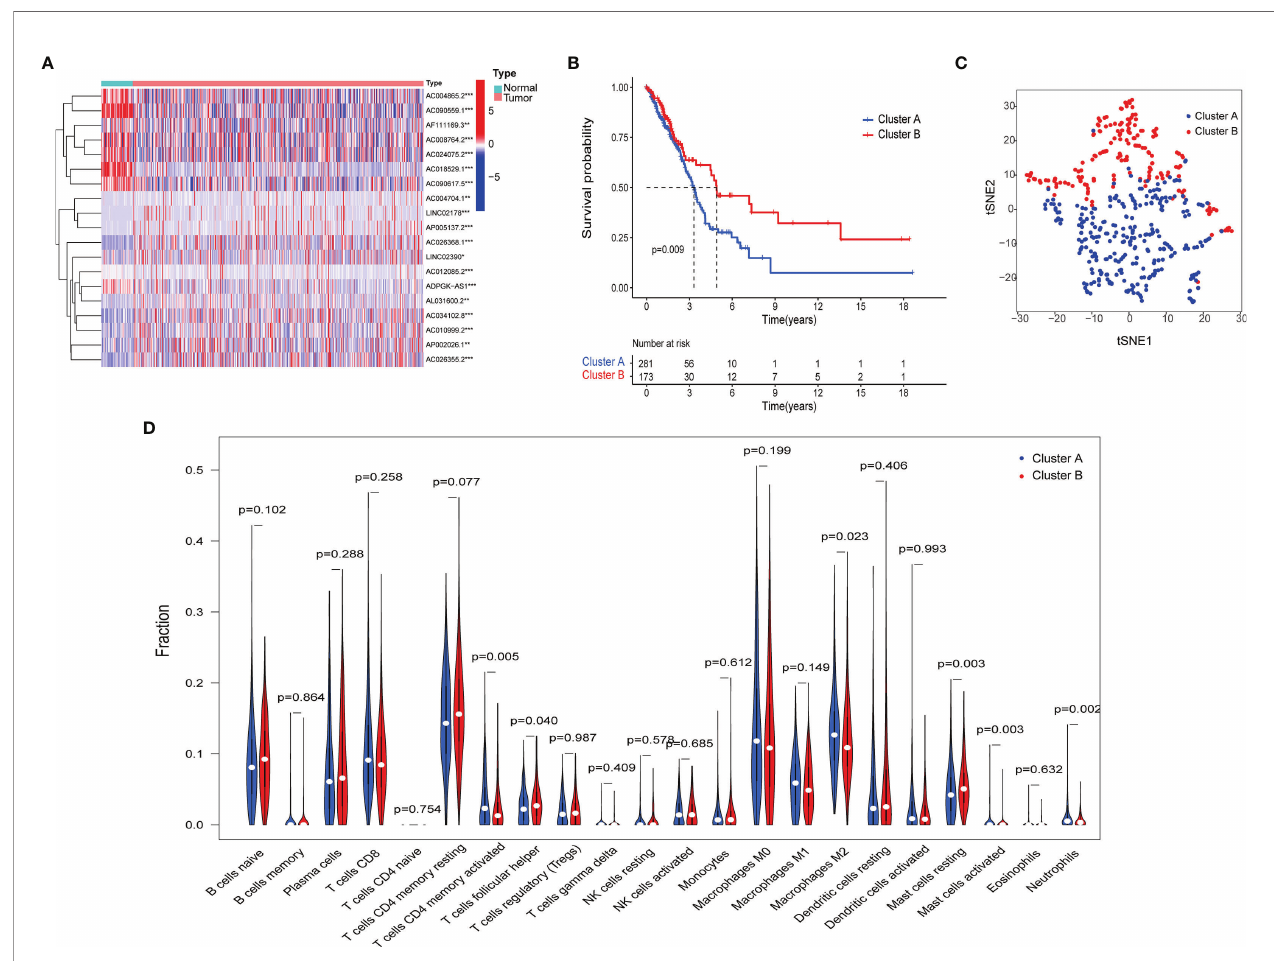
FIGURE 2 | Pyroptosis-related lncRNAs molecular patterns in the TCGA cohort. (A) Difference between normal and tumor tissue of 19 LncRNAs related to the prognosis of LUAD. (B) Kaplan – Meier method was used to plot the OS curve for the cluster A and B. (C) tSNE analysis of cluster A and B. (D) The in fi ltrating levels of 22 immune cell types in cluster A and cluster